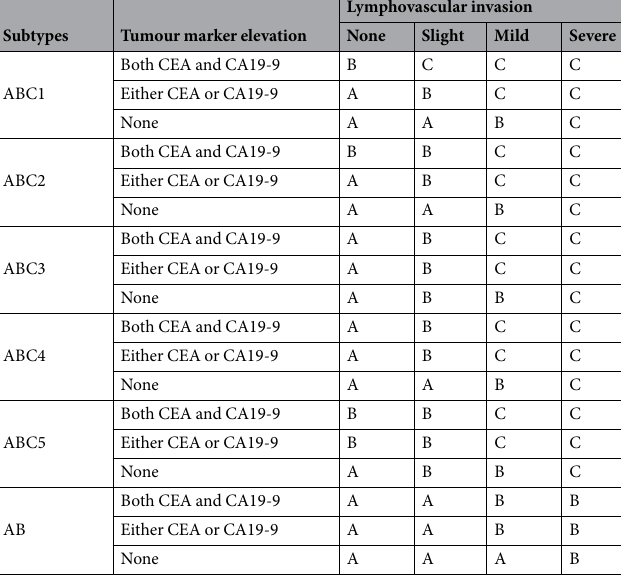
Table 1. Candidate subtypes were determined depending on the tumour marker elevation status and lymphovascular invasion status. CA19-9, Cancer antigen 19-9; CEA, Carcinoembryonic